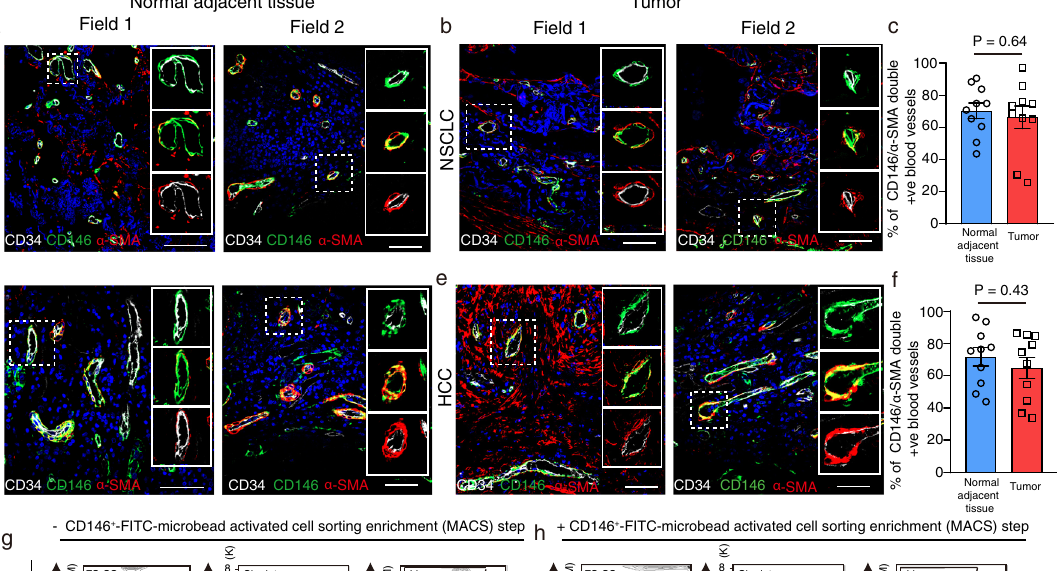
tissues and tumors derived from NSCLC and HCC patients almost by 7 – 13 folds as compared to FACS method alone (Fig. 1k, l). Compared with FACS method alone, our protocol enhanced the successful chance of isolating enough pericytes for subsequent culturing and characterization and functional studies (Supplementary fi g. 1). Overall, this method enabled us to obtain pure pericytes in culture with high reproducibility, mainly due to MACS enrichment method and temperature/